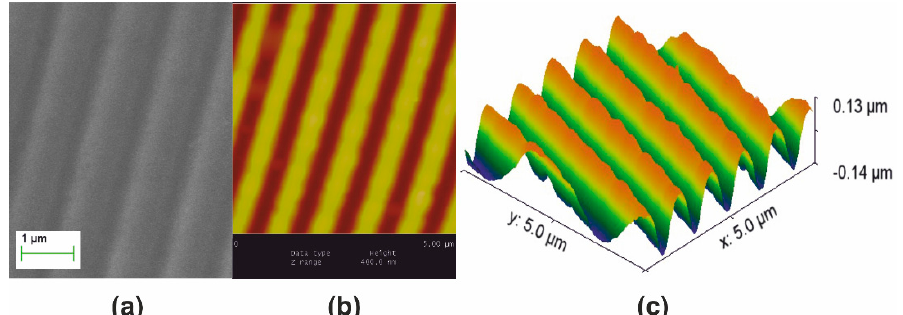
Figure 1. Polymeric master surface relief holographic grating used for molding aerogels and xerogels. Grating period Λ o = 1 μ m, groove depth ~ 200 nm: ( a ) SEM micrograph; ( b ) AFM image; and ( c ) AFM surface relief presentation.